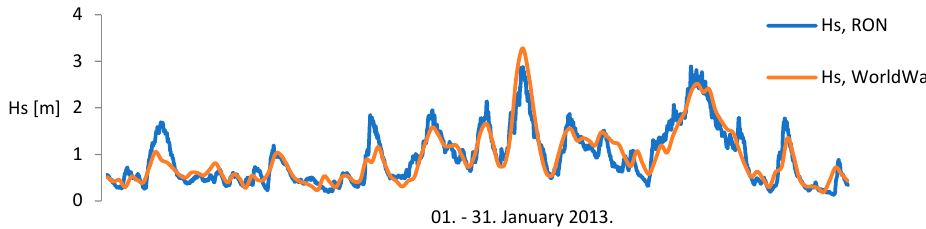
Figure 3. H s time series from WW database (location 4) and RON buoy “Ancona” (13°43 ′ 10 ″ E–43°49 ′ 26 ″ N) .